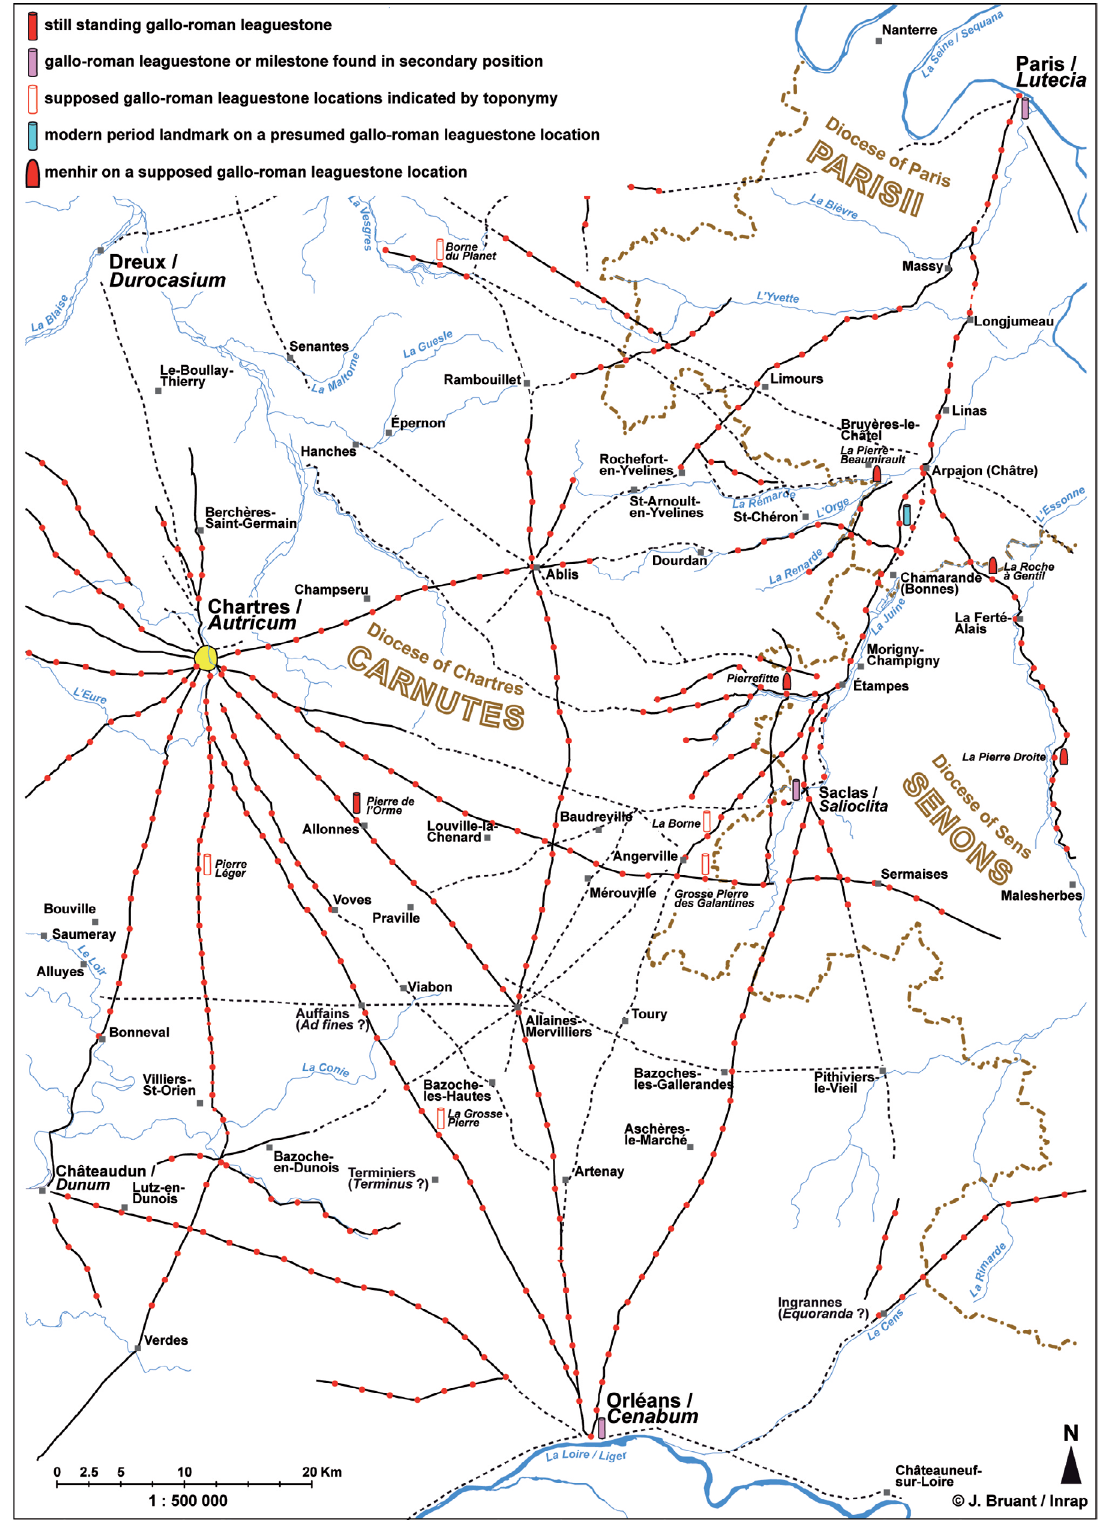
Figure 25. Presumed leaguestone location (2222 m) on the network of roads between Orleans/ Cenabum , Paris/ Lutecia and Chartres/ Autricum . © J.